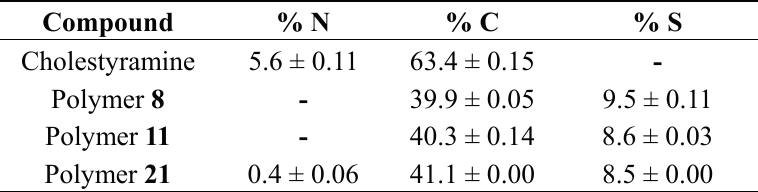
Table 1. Elemental analysis of the polymers selected [ 8 (l-CS), 11 (l-CX) and 21 (l-S_BPY); l = low DVS:saccharide stoichiometry, C = β -CD, X = dextrin, = starch; BPY = bis(2-hydroxyethyl)amine] for animal experimentation.